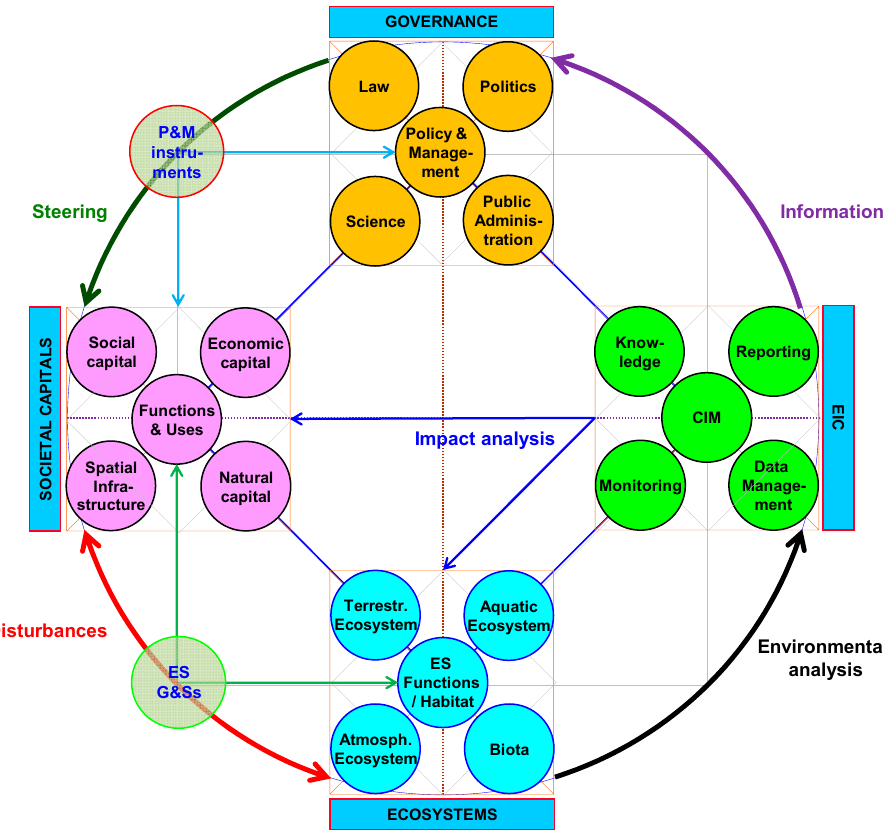
Figure 1. The Pentatope Model (PTM). PTM shows the way that Governance, Societal Capitals, Ecosystems, and the Environmental Information Cycle (EIC) interact: disturbances between Societal Capitals must be analyzed in order to provide information to governance. Governance—in particular, policy and management (P&M) instruments—allows steering of the Societal Capitals. Disturbances of ecosystems are caused by the use or exchange of ecosystem goods and services (ES G&Ss). The fifth PTM framework, DPSIR, cannot be easily shown in this figure.